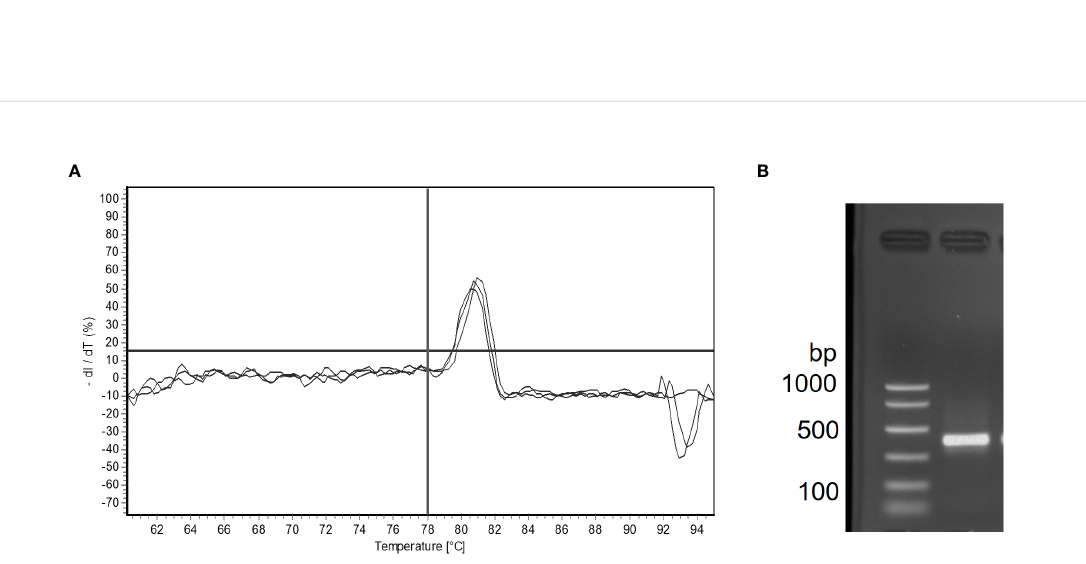
Figure S2), which was the same observed T m of both M. quahogii gDNA and plasmid standards. From the positive samples, 6 samples from each sample type (n=18) were randomly selected and visualized by agarose gel electrophoresis, from which the target amplicon was gel-puri fi ed and Sanger sequenced. All 18 samples had > 99% sequence identity to M. quahogii (QPX) sequences in NCBI GenBank. Average sample PCR ef fi ciency and linearity were 91.8% ± 3.3 (SD) and 0.99 ± 0.007 (SD) (Table 2),